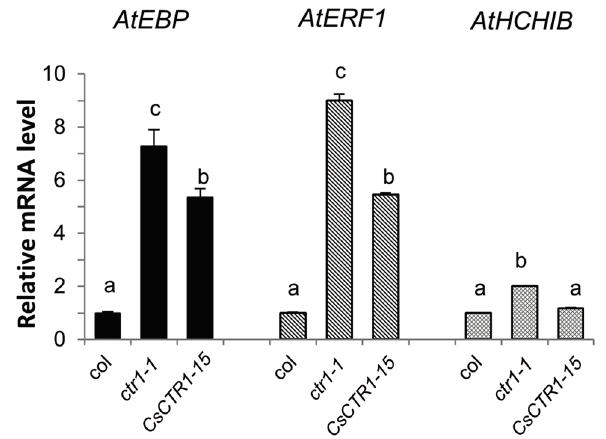
Figure 6. Expression analysis of AtEBP , AtERF1 and AtHCHIB in Arabidopsis transgenic line 15. col: Columbia-0, ctr1-1 : Arabidopsis ctr1-1 mutant. Arabidopsis Aactin 2 was used as internal control for qRT-PCR. Error bars on each column indicate standard deviation from three biological replicates. The statistical significance was determined by Duncan’s multiple comparison tests. Different letters above bars indicate significant differences ( p < 0.05). The same letter indicates no significant difference ( p < 0.05).